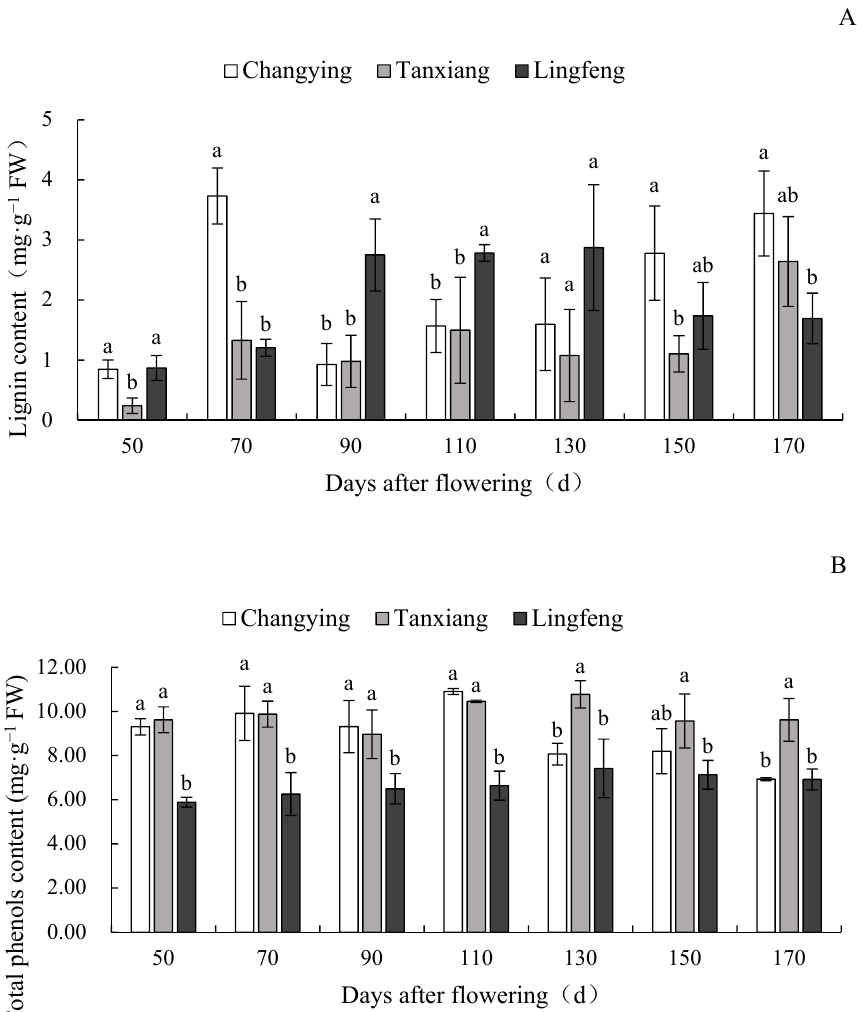
Figure 5. Concentrations of lignin and total phenols among three Chinese olive cultivars at different fruit developmental stages. Different letters indicate significant differences between different varieties within each stage ( p < 0.05). ( A ) Lignin, ( B ) Total phenols.